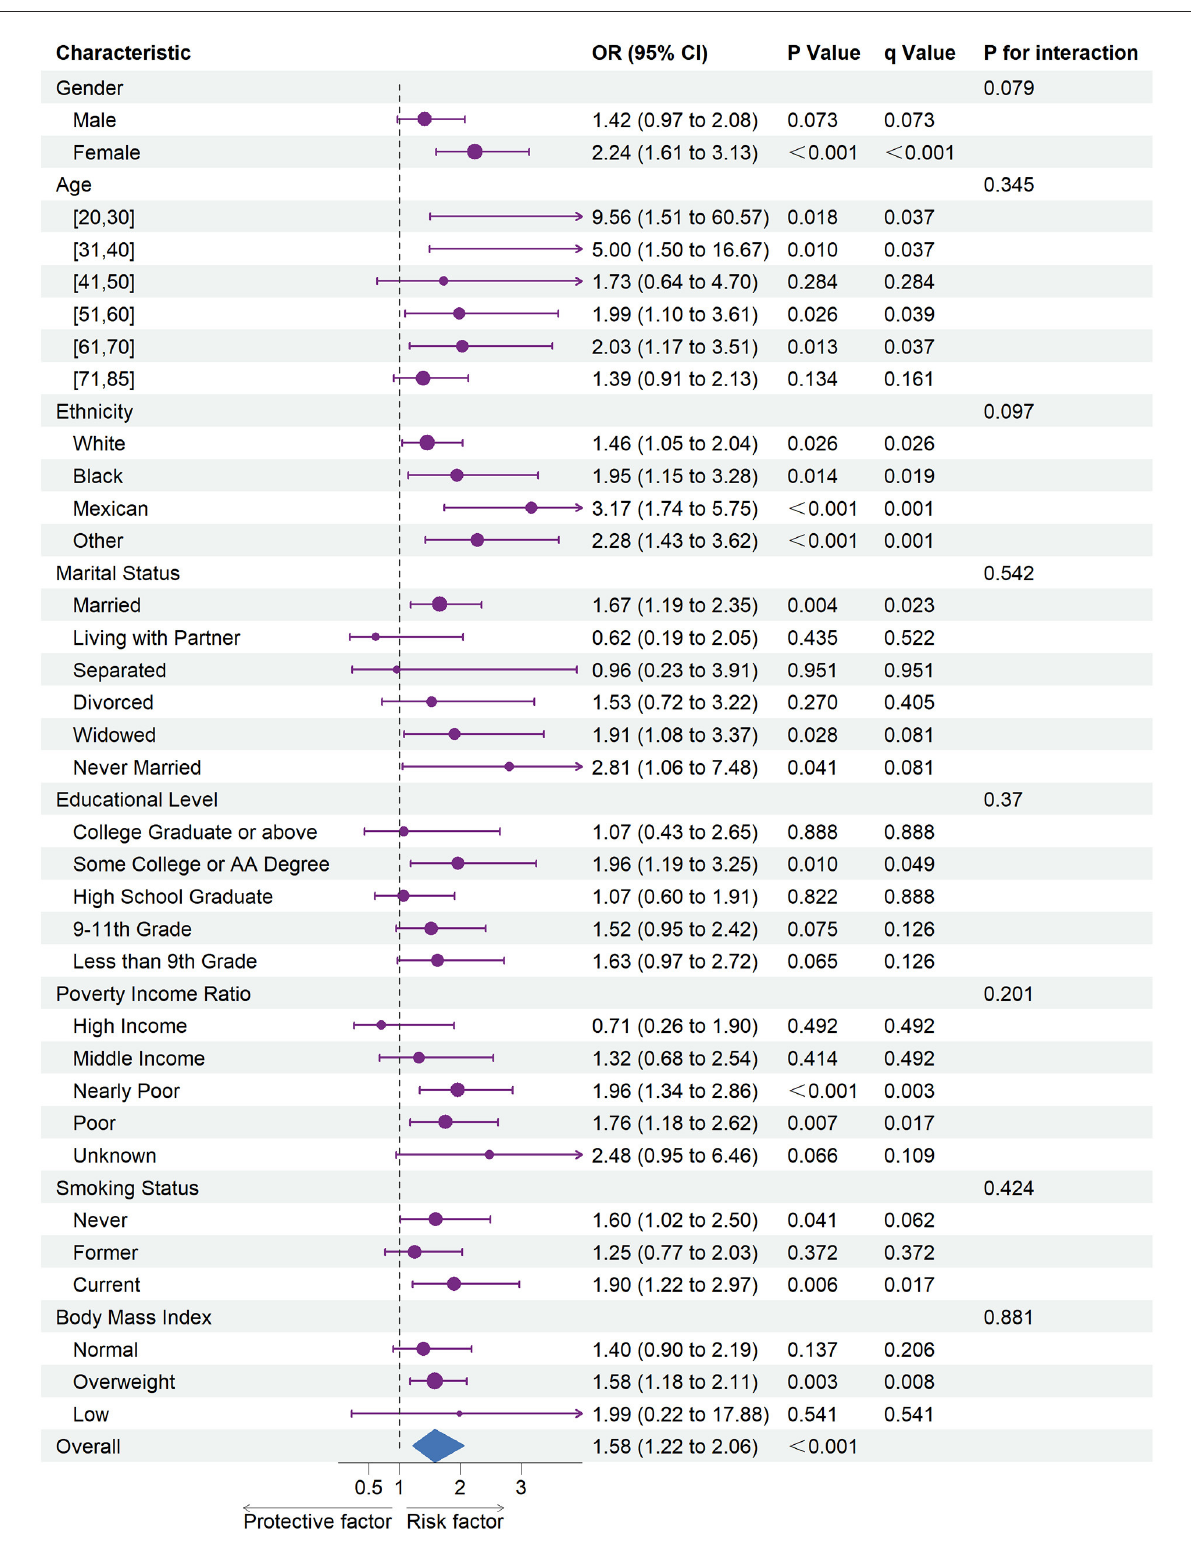
FIGURE1 The association between depression and coronary heart disease risk in each subgroups. OR, odds ratio; CI, confidence